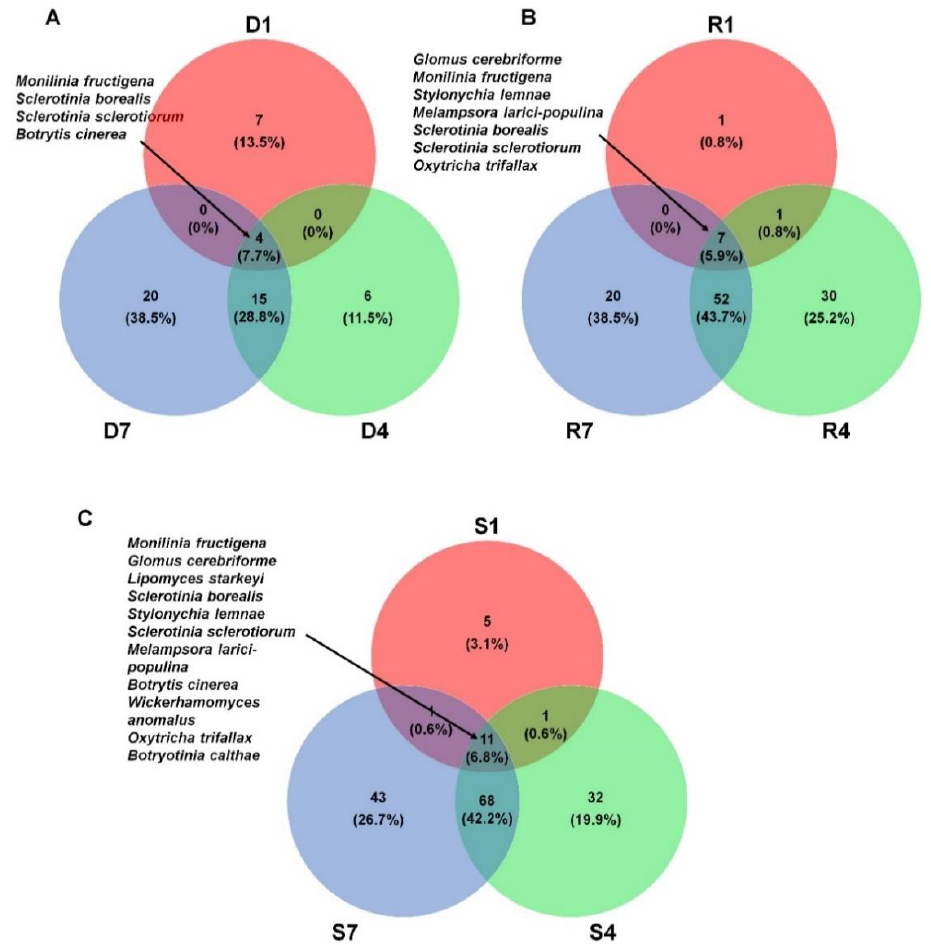
Figure 6. Comparison of identified fungal species in three different samples. Venn diagram showing commonly identified fungal species among three different DNA libraries ( A ), three different RNA libraries ( B ), and three different samples ( C ). For comparison, we only selected fungal species with the number of reads more than 100 in each sample. The numbers indicate the number of identified fungal species and the proportion in each sample.